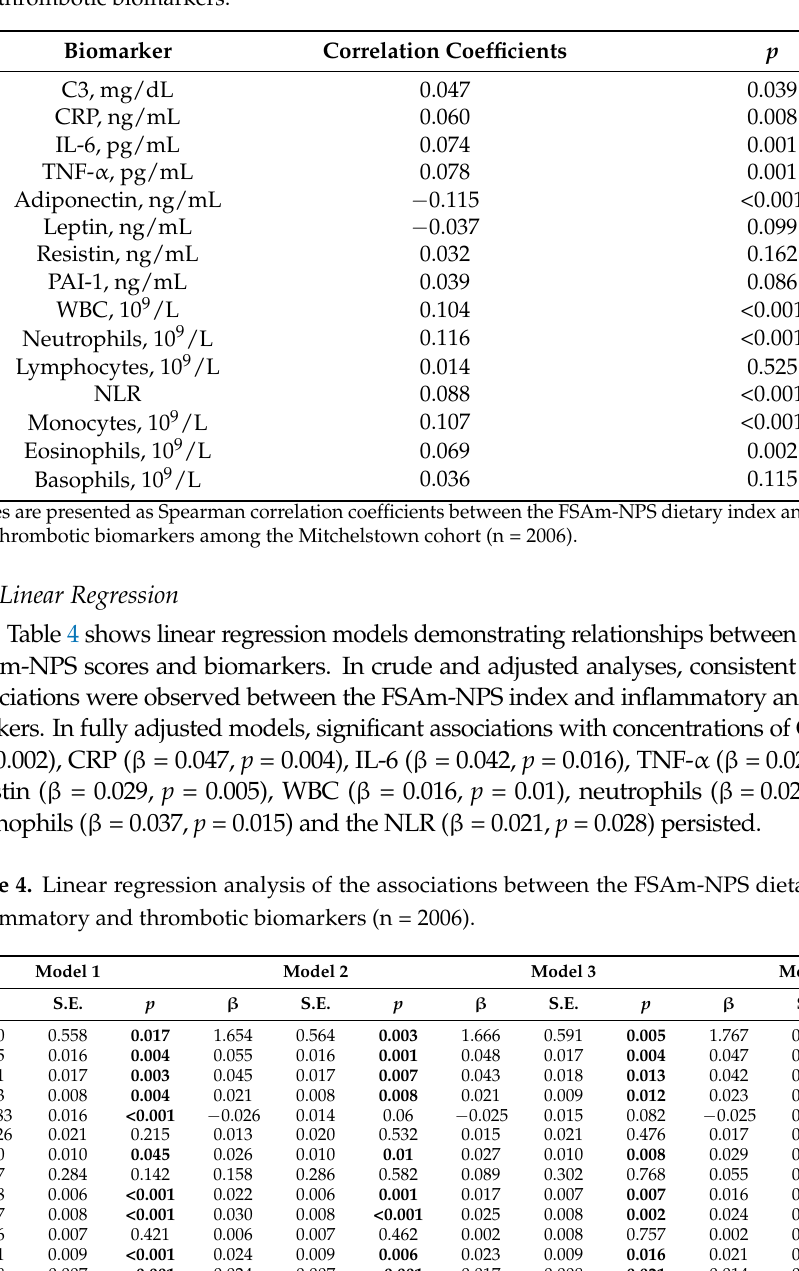
Table 3. Spearman correlation coefficients between the FSAm-NPS dietary index and inflammatory and thrombotic biomarkers.